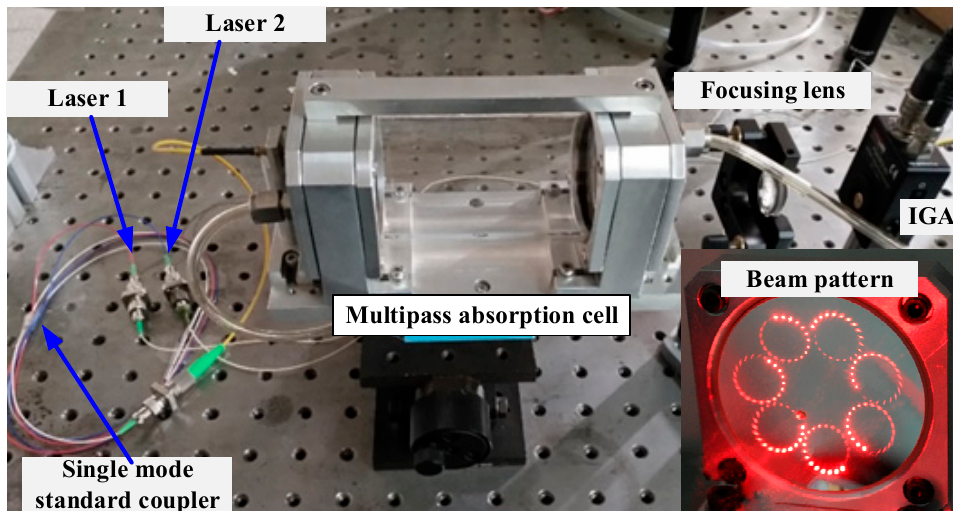
Figure 2. Photograph of the dual-gas sensor associated with a beam pattern (shown with a red laser) on one mirror of a home-made dense-pattern multipass cell.